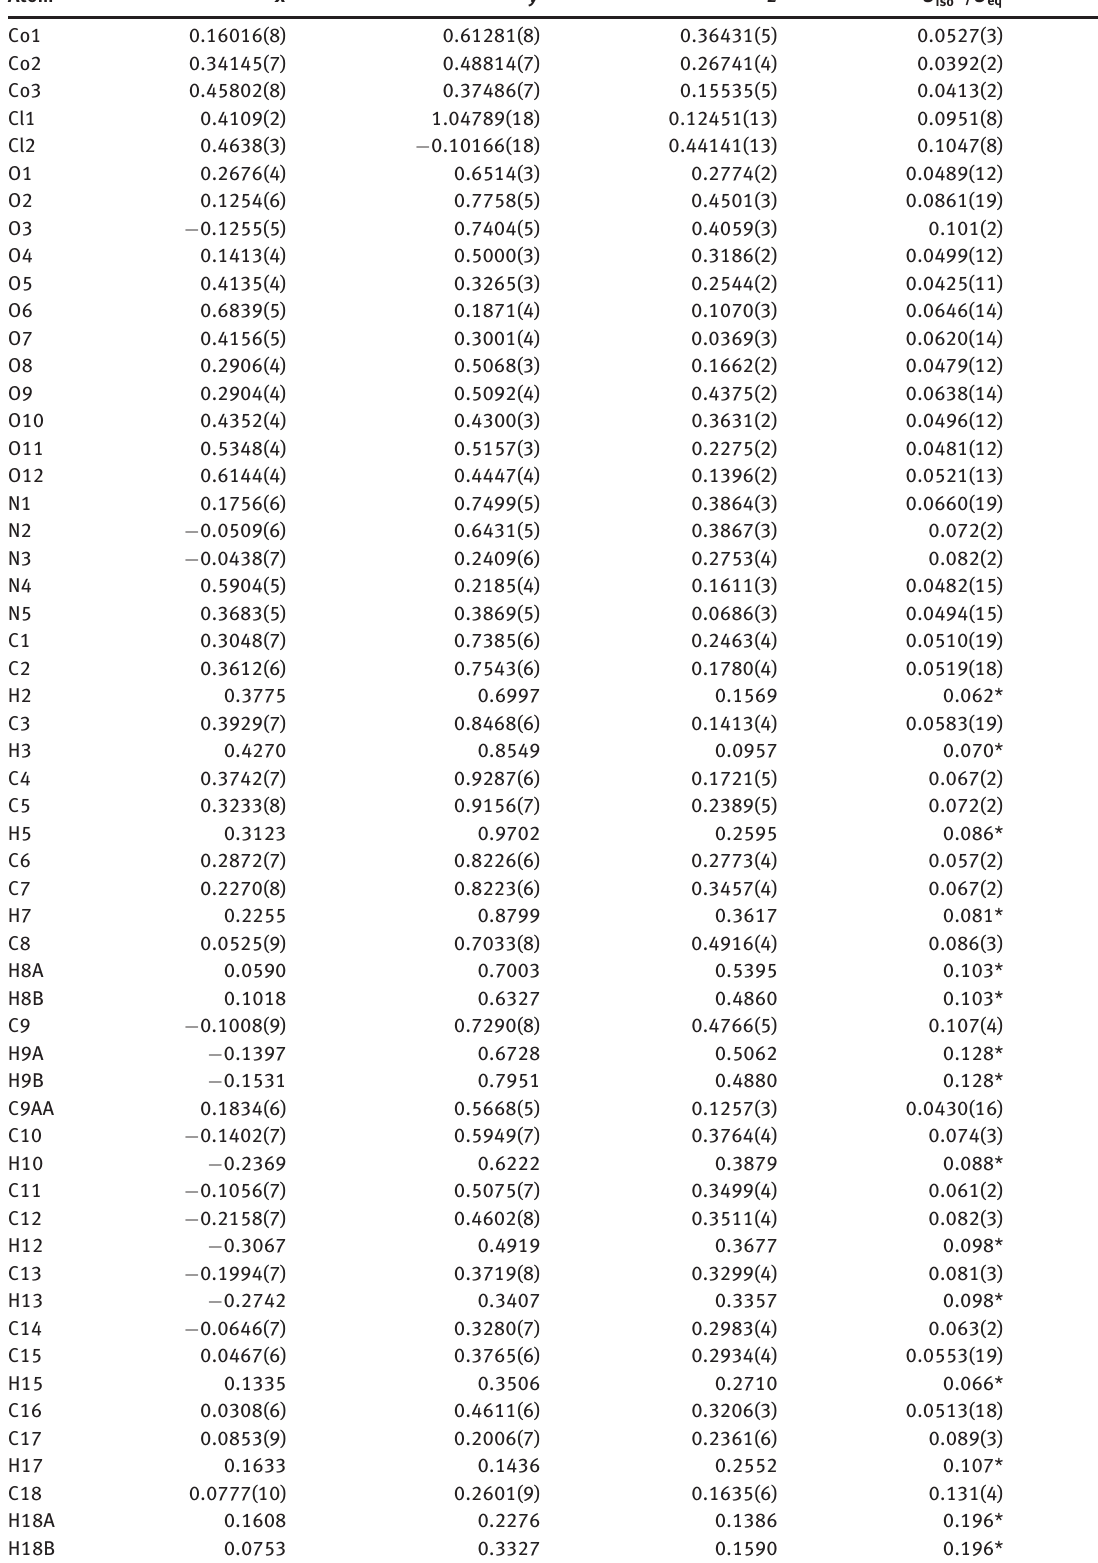
Table 2: Fractional atomic coordinates and isotropic or equivalent isotropic displacement parameters (Å 2